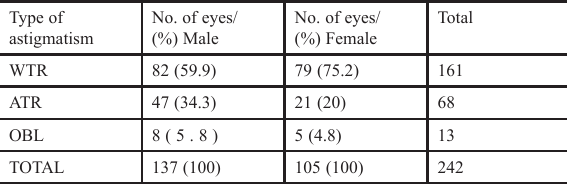
Table 5 Distribution of various types of astigmatism (according to their axes) in relation to gender. With - the-rule astigma tism (66%) was more common than the other